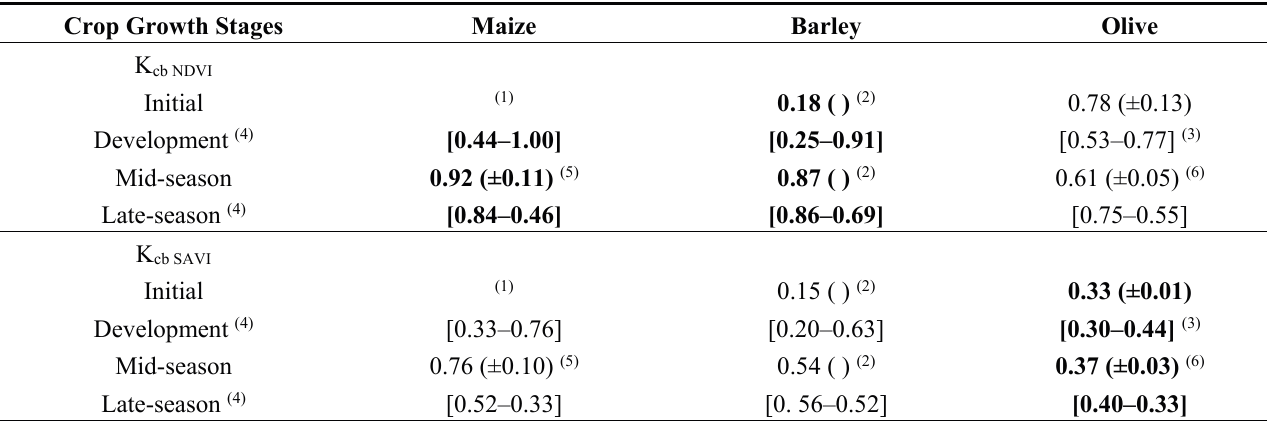
Table 6. Average and standard error of the mean or the range of the actual daily basal crop coefficients estimated with vegetation indices for the various crops and crop growth